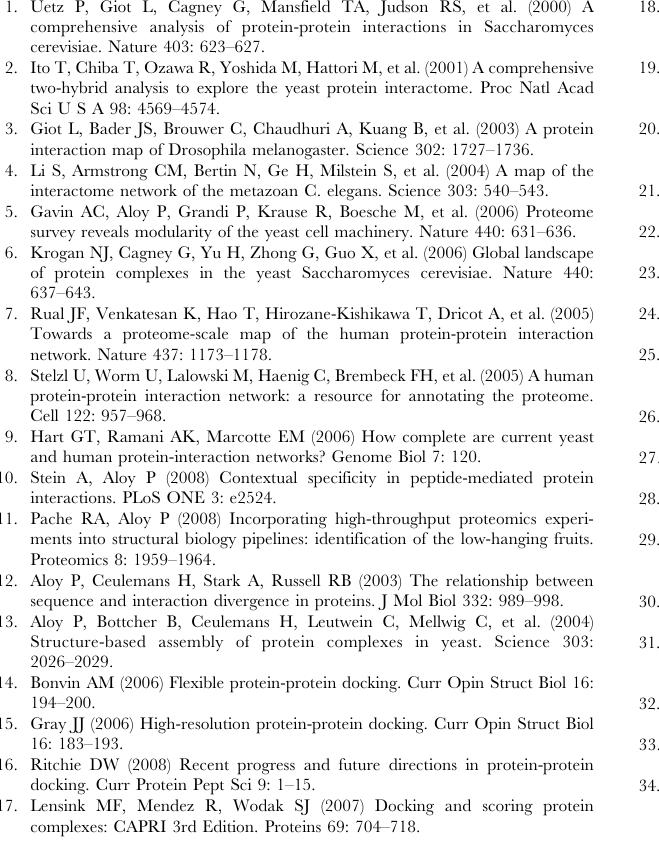
Table S5 Distribution of the good cases between the different difficulty levels in the Benchmark 3.0 dataset. The results are referred to the predictions provided by ZDOCK 3.0 alone, without the pyDock rescoring. Table S6 Success rate for the CAPRI predictors participating in at least 12 targets. Successful targets are those targets for which at least one prediction was classified as acceptable. Table S7 Results of the simulation of an alanine scanning experiment. Refer to the Supplementary Text S1 for the